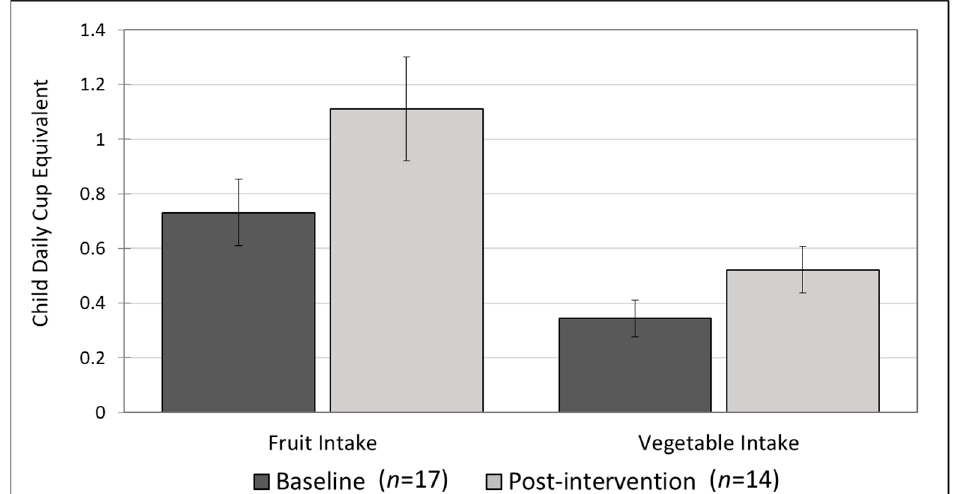
Figure 2. Child fruit and vegetable intake. Average adult-reported child fruit and vegetable intake at baseline ( n = 17, t -test p = 0.09) and post-intervention ( n = 14, t -test p = 0.1). Bars are group means and error bars are standard error of the mean.